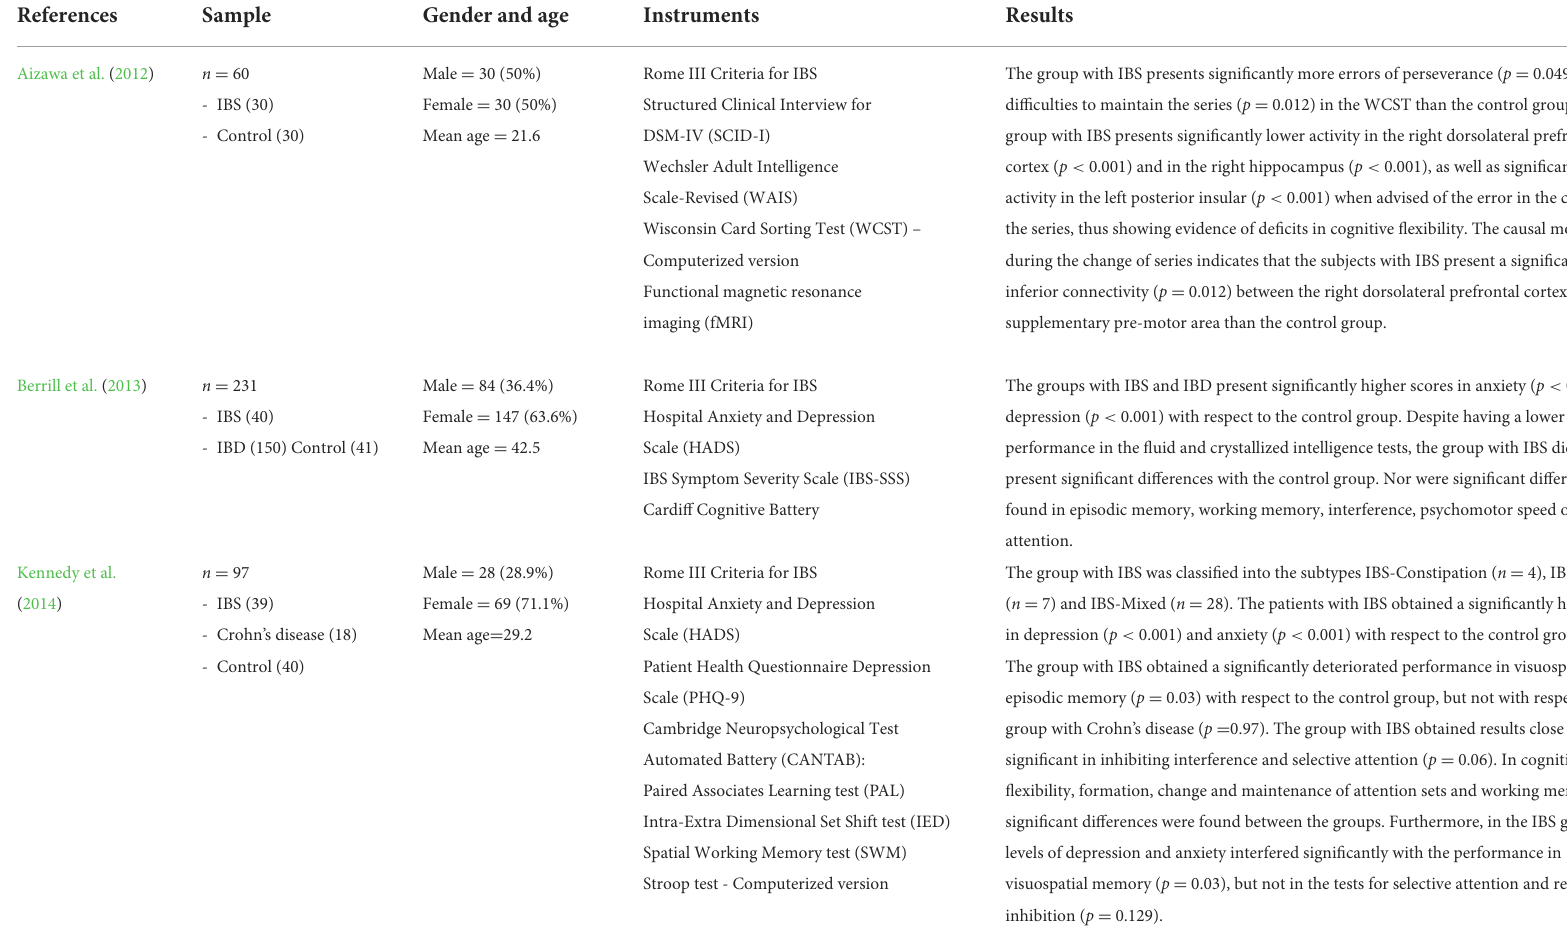
TABLE 3 Neuropsychological